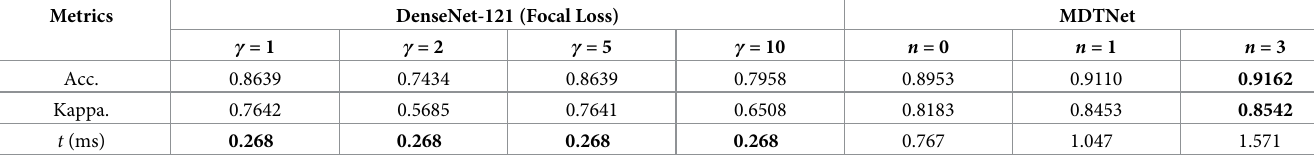
Table 2. Performance of MDTNet models for severity grade prediction.